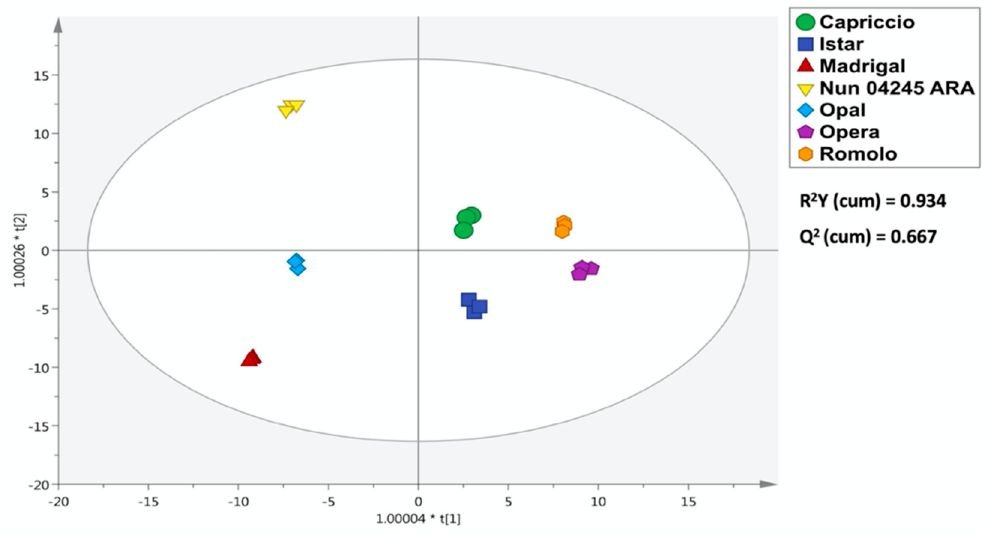
Figure 2. Heat map from unsupervised hierarchical cluster analysis ( A ) and principal component analysis (PCA) score plot ( B ) built considering the phytochemical profile of the different artichoke cultivars. In the PCA score plot, the distribution of Quality Control (QC) sample replicates is also showed.